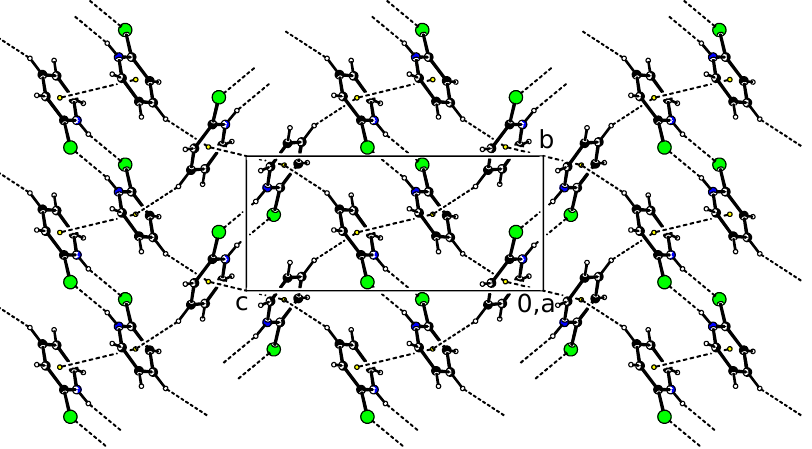
Figure 2. Weak intermolecular interactions in the crystal structure of (I) . Projection along the crystal- lographic a axis. N–H · · · S hydrogen bonds, antiparallel π · · · π stacking and C–H · · · π interactions are shown as dashed